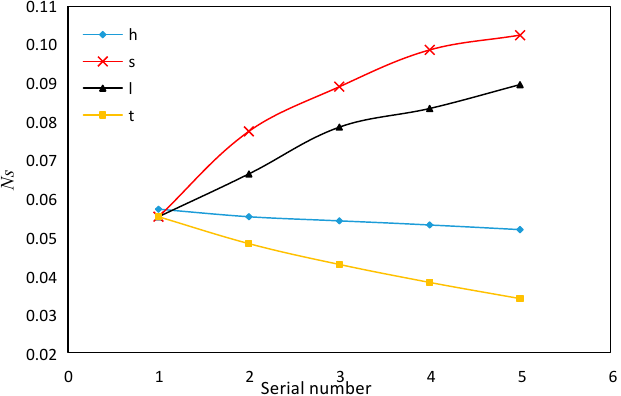
Figure 16. E ff ect of fi n structure parameter on N s .